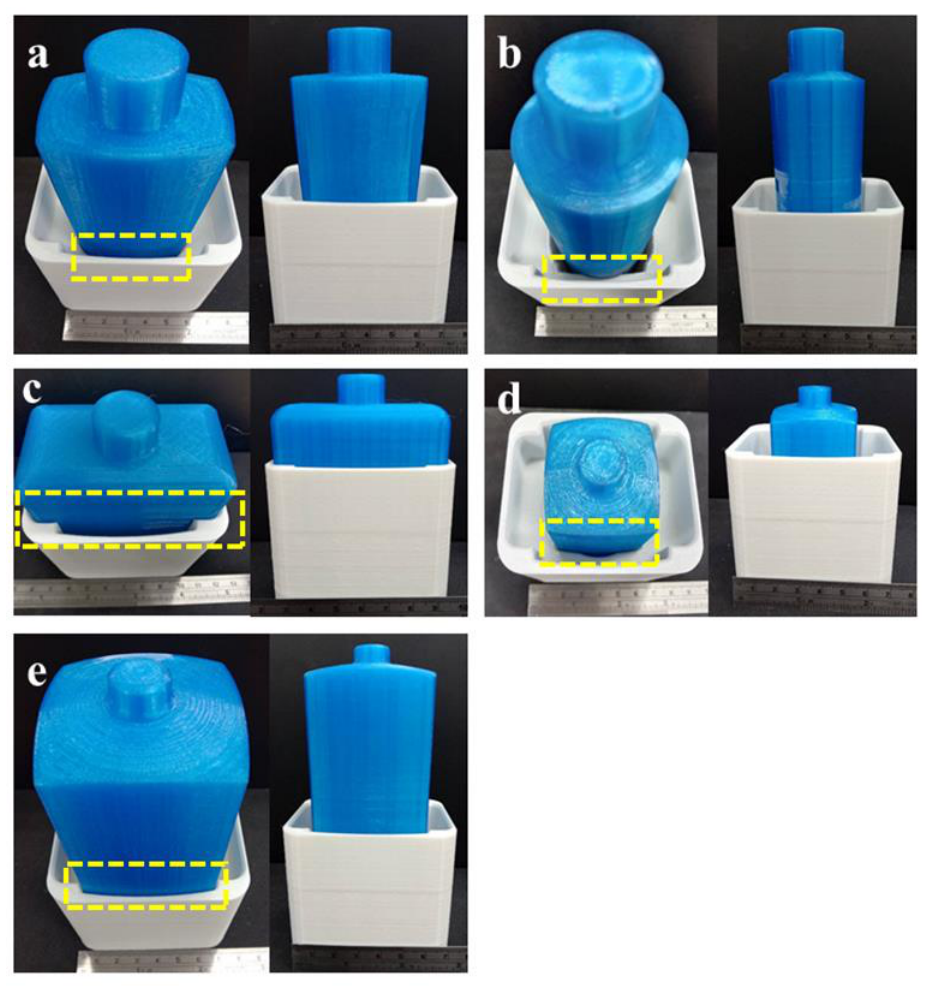
Figure 11. 3D-printed bottles being placed in the universal puck ( a ) bottle 1 ( b ) bottle 2 ( c ) bottle 3 ( d ) bottle 4 ( e ) bottle 5. Table 5. Fabrication and mechanical properties comparison of the empty and foam-filled universal